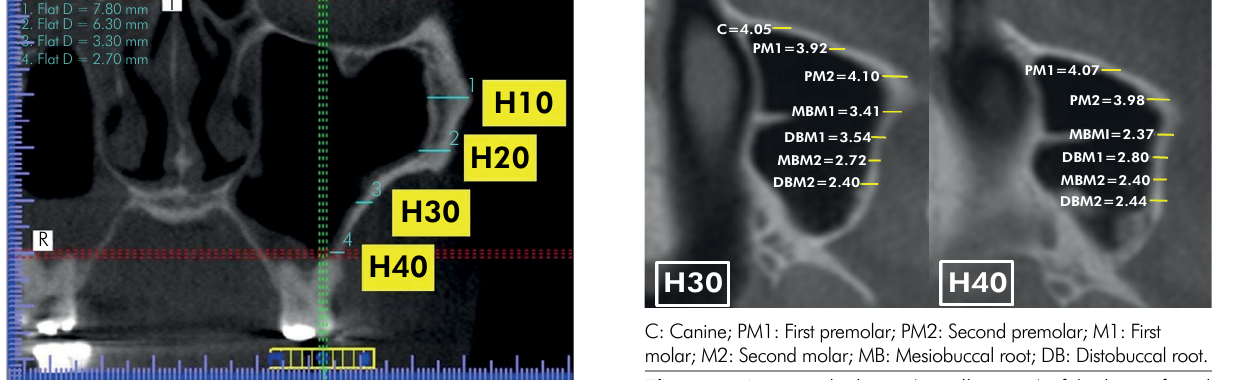
Figure 5. Average thickness (in millimeters) of the buccofacial sinus wall at H30 and H40 in axial view. Figure 3. A typical coronal view of the sites of